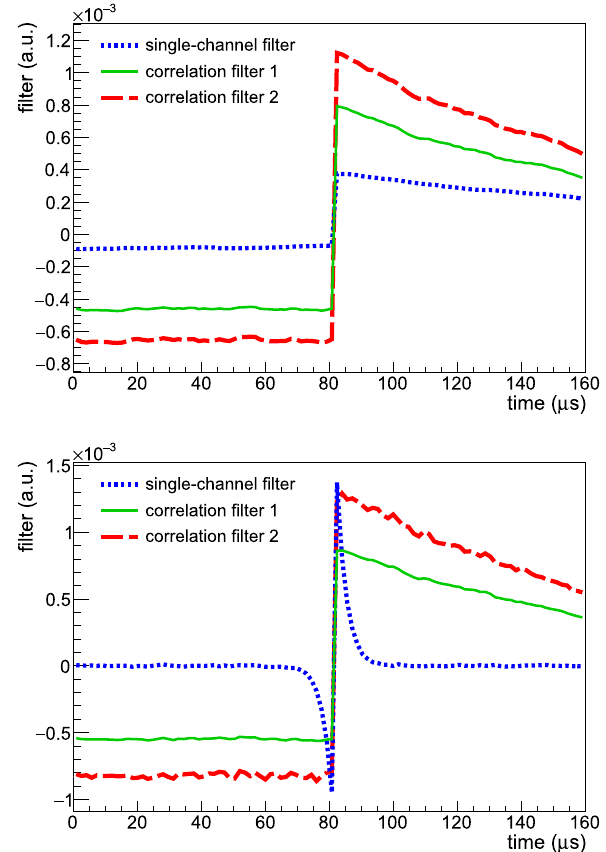
Fig. 13 DPLMS optimum filter synthesis with correlated noise between two simulated channels. The blue dashed line is the single- channel filter, the green continuous line is the correlated filter for the first channel and the red long-dashed line is the correlated filter for the second channel